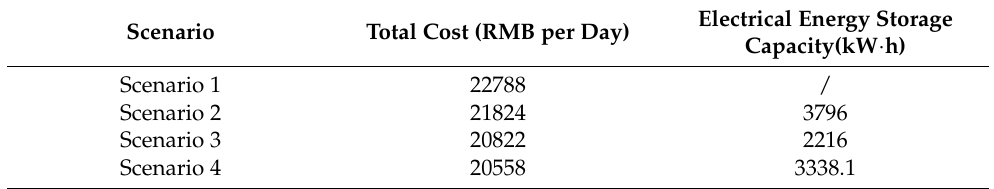
Table 3. Results of total cost and electrical energy storage capacity in different